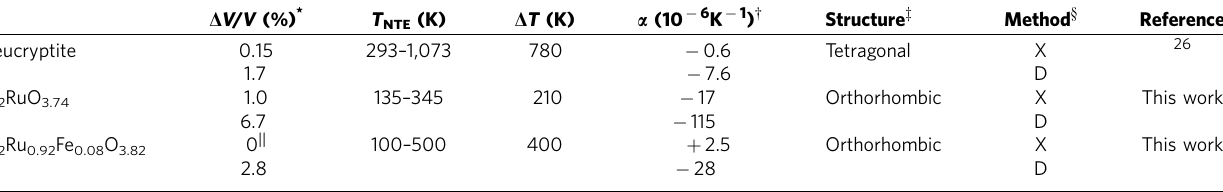
Table 3 | Parameters related to negative thermal expansion for materials with highly anisotropic structural